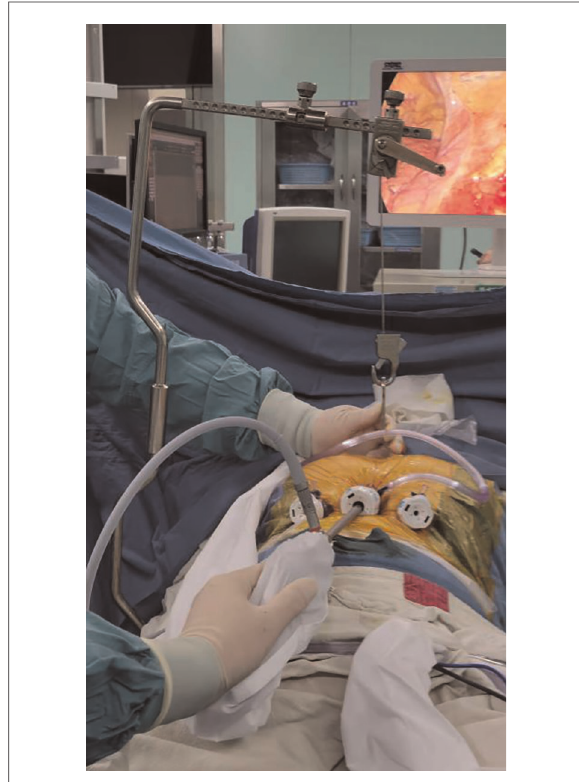
FIGURE 1 Modi fi ed subxiphoid approach for resection of a retrosternal goiter. A 10 mm trocar was placed in the subxiphoid area, and two 5 mm trocars were placed below the bilateral costal arch. A sternal retractor was used to enlarge the operative